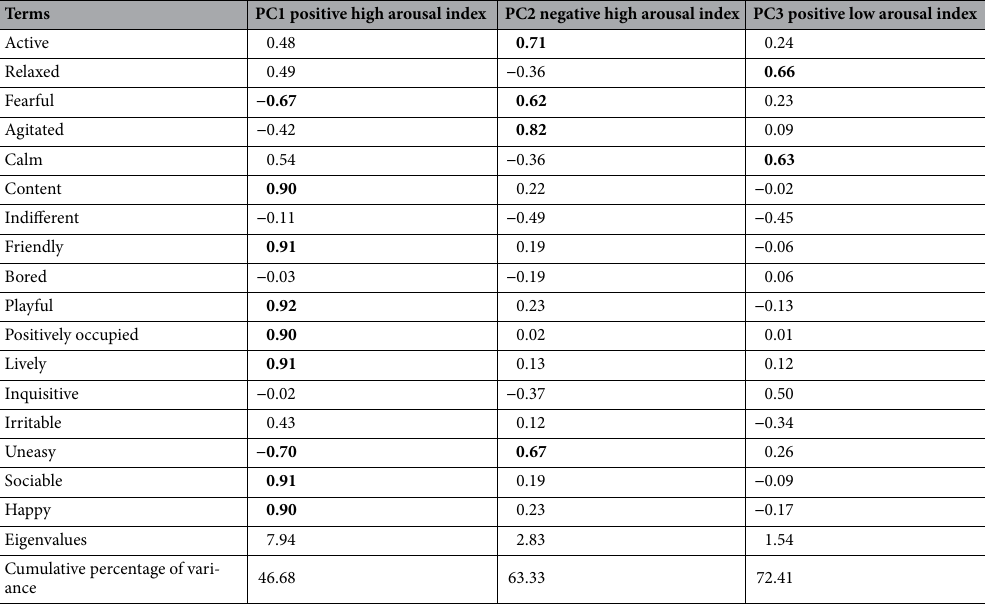
Table 3. Principal component analysis of QBA. Terms with loadings > 0.6 are bolded and were used to define the indexes identified in the